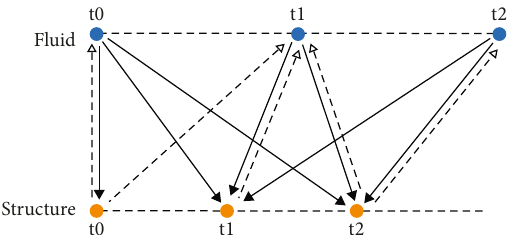
Table 1: Bleich–Sandler parameter configuration.